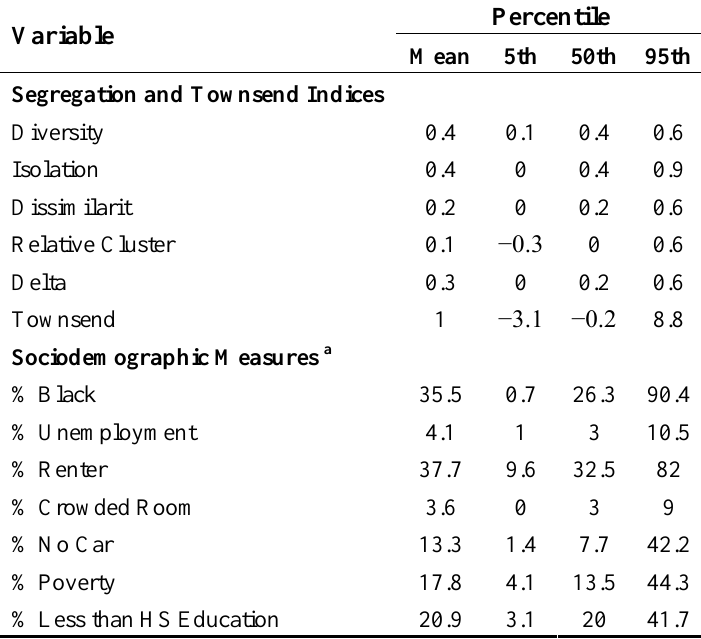
Table 1. Summary of segregation indices, townsend index, sociodemographic measures, and lifetime air toxics cancer